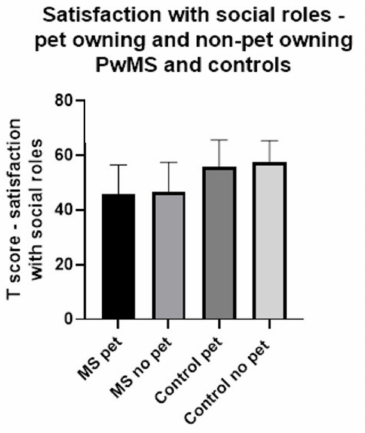
Figure 2. Comparison of satisfaction with social roles between pet owners and non pet owners with and without